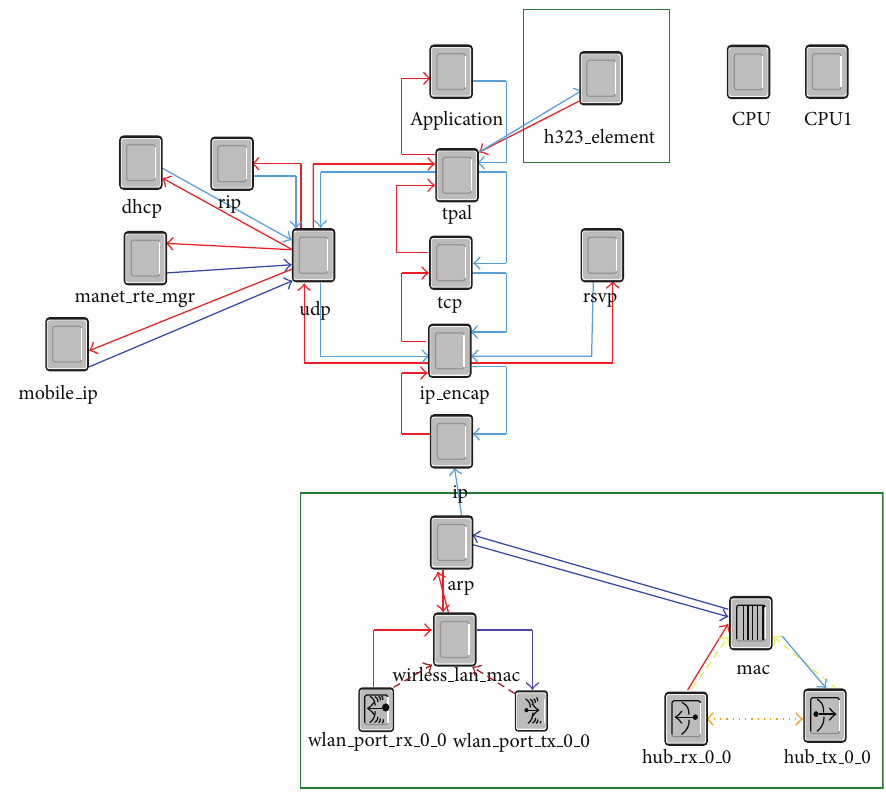
Figure 3: The node model of new created